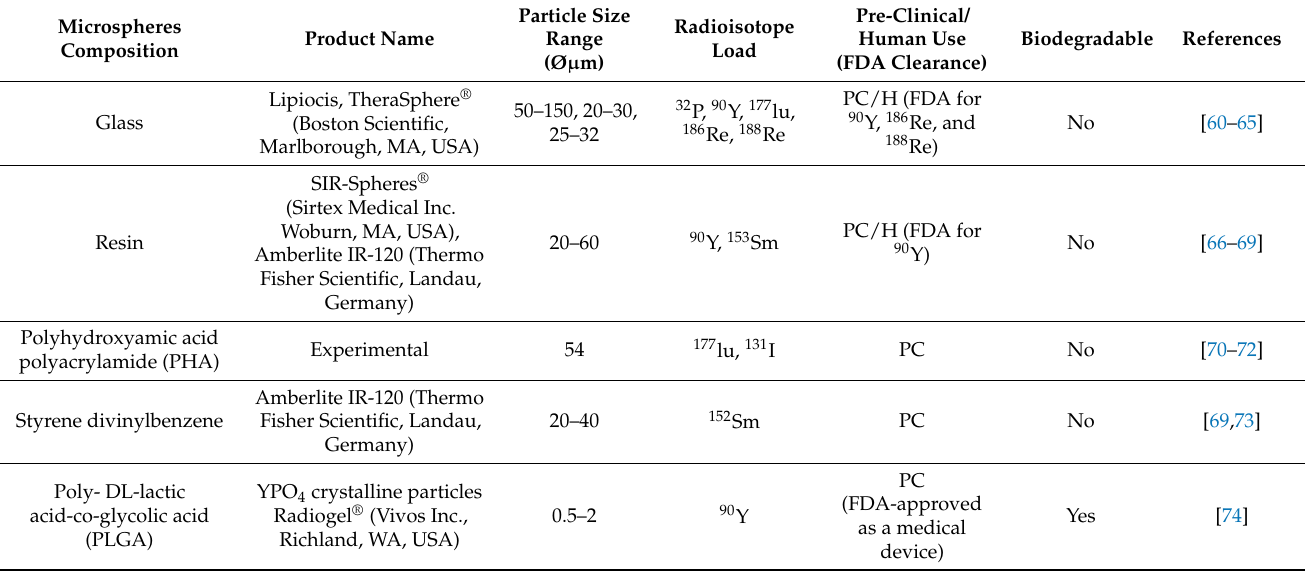
Table 4. Microspheres used for trans-arterial radioembolization (TARE). PC = pre-clinical use, H = human use, FDA = FDA approved as an active implantable medical device. See Section 4 for a detailed evaluation of the